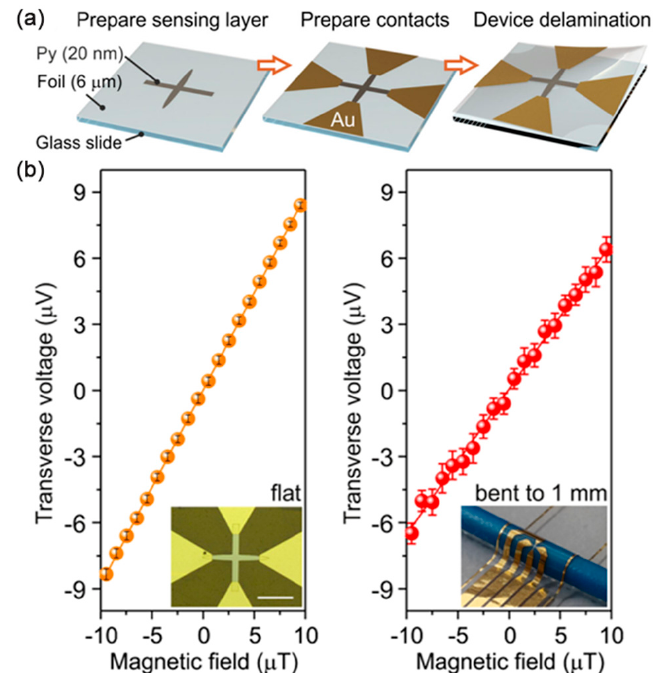
Figure 6. ( a ) Schematics on the fabrication process of flexible PHE sensor; ( b ) Magnetoelectrical characterization of flexible PHE sensors in flat state and bent to 1 mm. Adapted with permission from Ref. [36] and licensed under CC BY 4.0. Copyright 2019, copyright Springer Nature